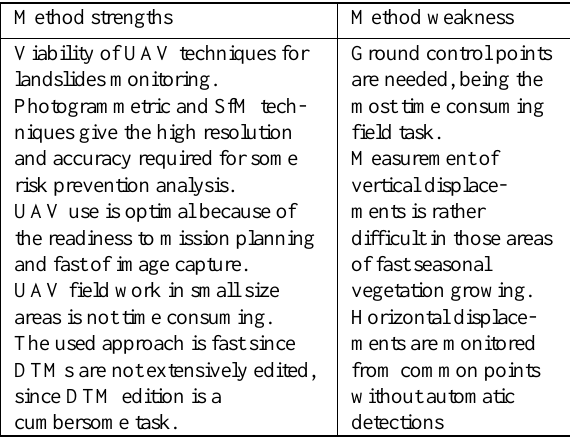
Table 4. Strengths and weakness of the methodology used in this